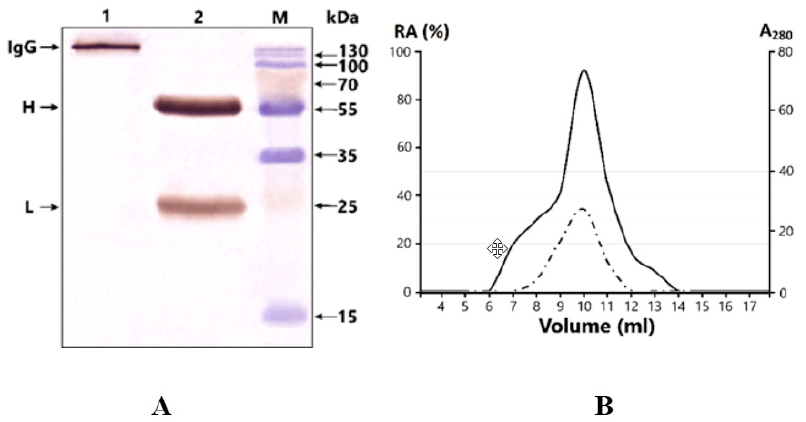
Figure 1. ( A ) SDS-PAGE analysis of homogeneity IgG in 12.5% gel followed by silver staining. Lane 1—intact IgG; lane 2—IgG incubated with 40 mM DTT at 100 °C (conditions for the complete reduction of disulfide bonds); lane M—protein molecular weight markers. ( B ) FPLC gel filtration on Superdex200 column of IgGmix in an acidic buffer (100 mM Gly-HCl, pH 2.6) after IgG preincubation in the same buffer. Absorbance at 280 nm (A280); the relative activity (%) of the obtained fractions in the hydrolysis MBP.